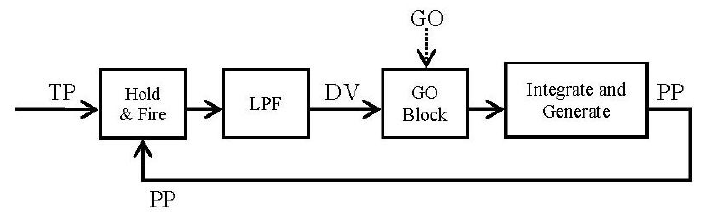
Figure 5. Block diagram generated from existing spikes processing blocks. The Spike Hold & Fire block performed the subtraction between the present position and the target position; both signals are spike streams. The GO block allows speed control of the movement and it will be explained in the next section. The Spikes Integrate & Generate (I & G) block allows us to integrate the DV (Difference Vector) signal (again a spike stream). This block is composed by a spike counter and a spike generator. The latter uses a parameter called Integrate & Generate Frequency Divider (IG_FD) to divide the clock signal and generate the output stream according to this